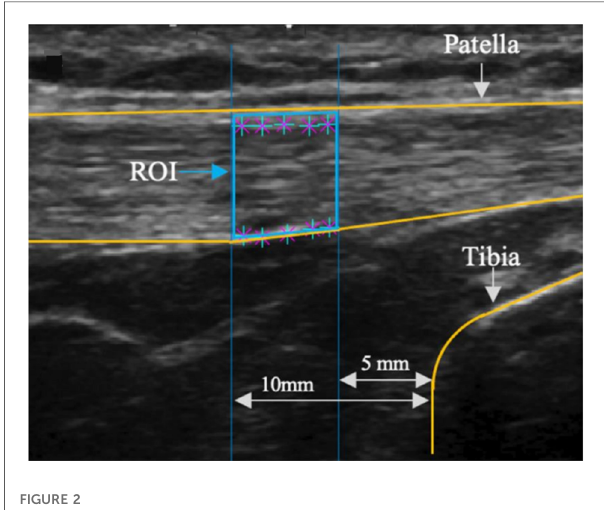
FIGURE 2 Ultrasound image of patellar tendon. ROI, region of